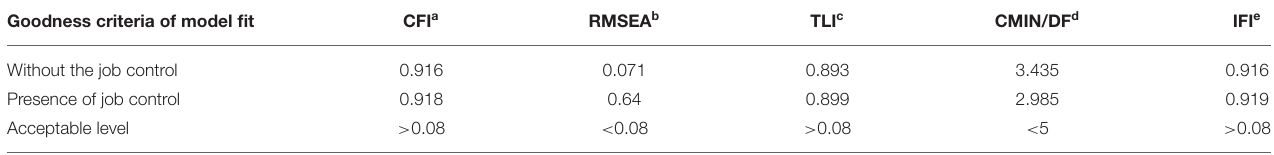
TABLE 4 | Goodness criteria of model fit in relationship between mental workload, job satisfaction, and moderating variable of job control. Goodness criteria of model fit CFI a Without the job